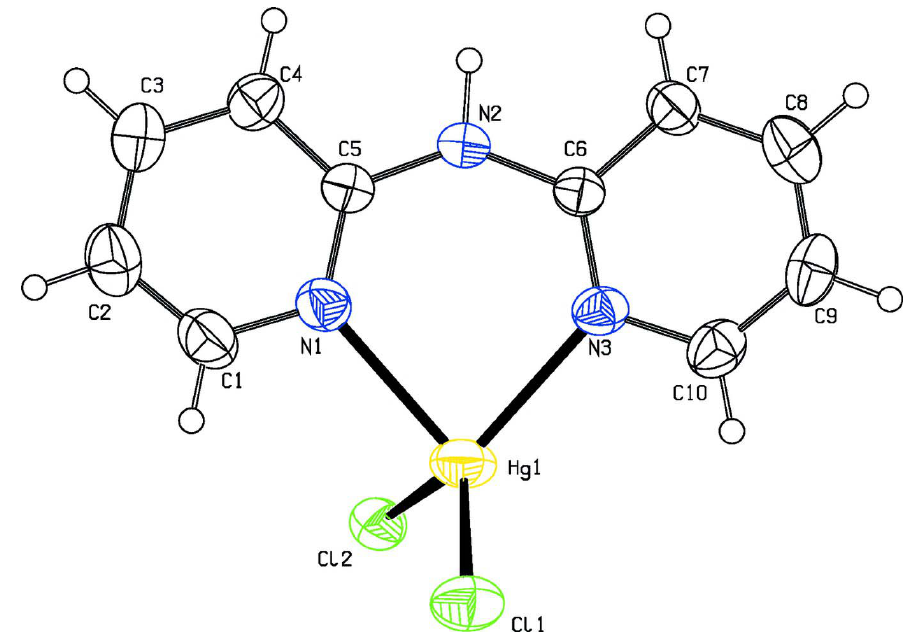
Figure 1 The molecular structure of the title molecule, with the atom-numbering scheme. Displacement ellipsoids are drawn at the 40% probability level.